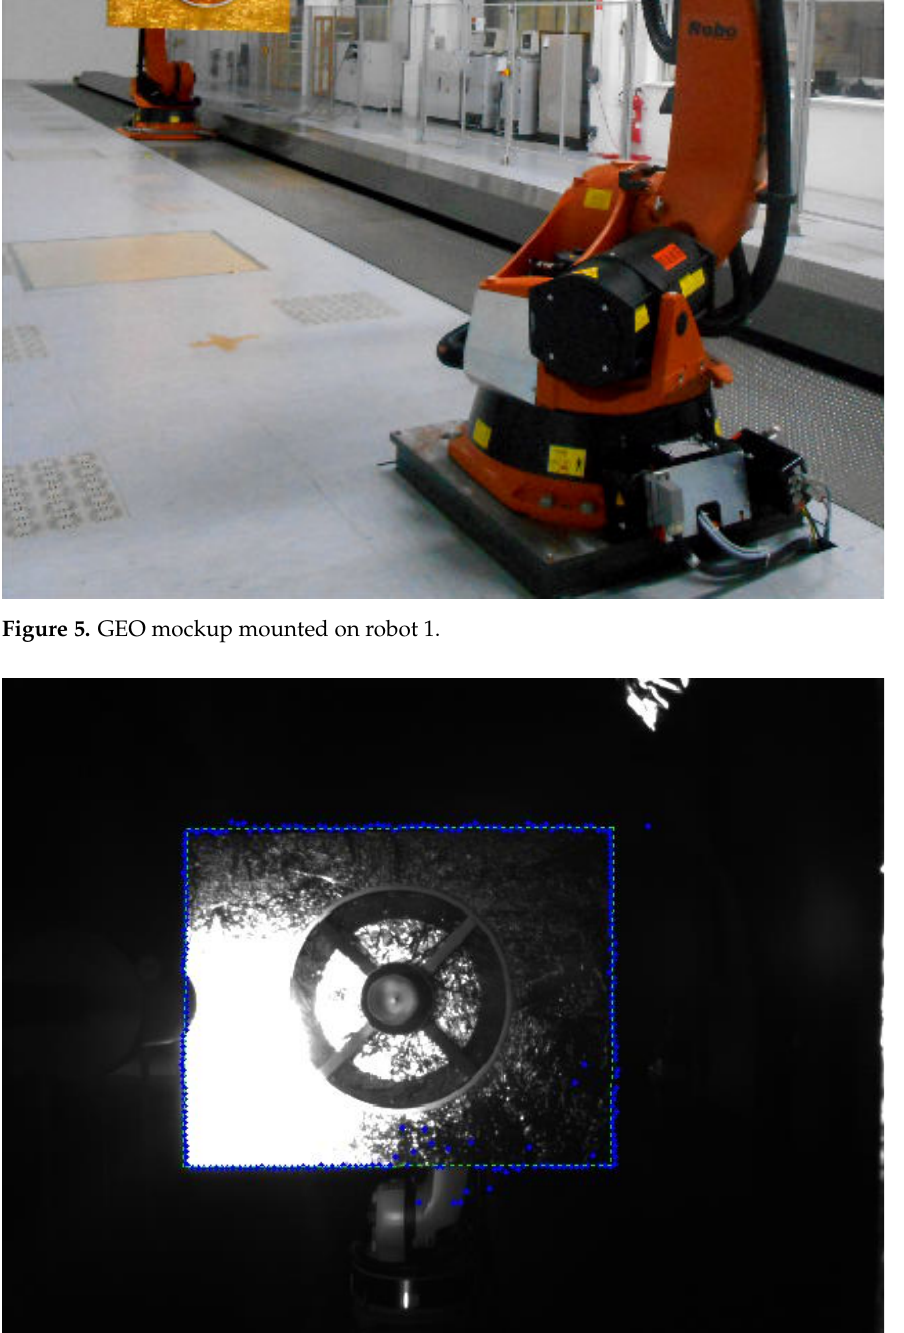
Figure 6. Tracked egdes of GEO mockup under realistic